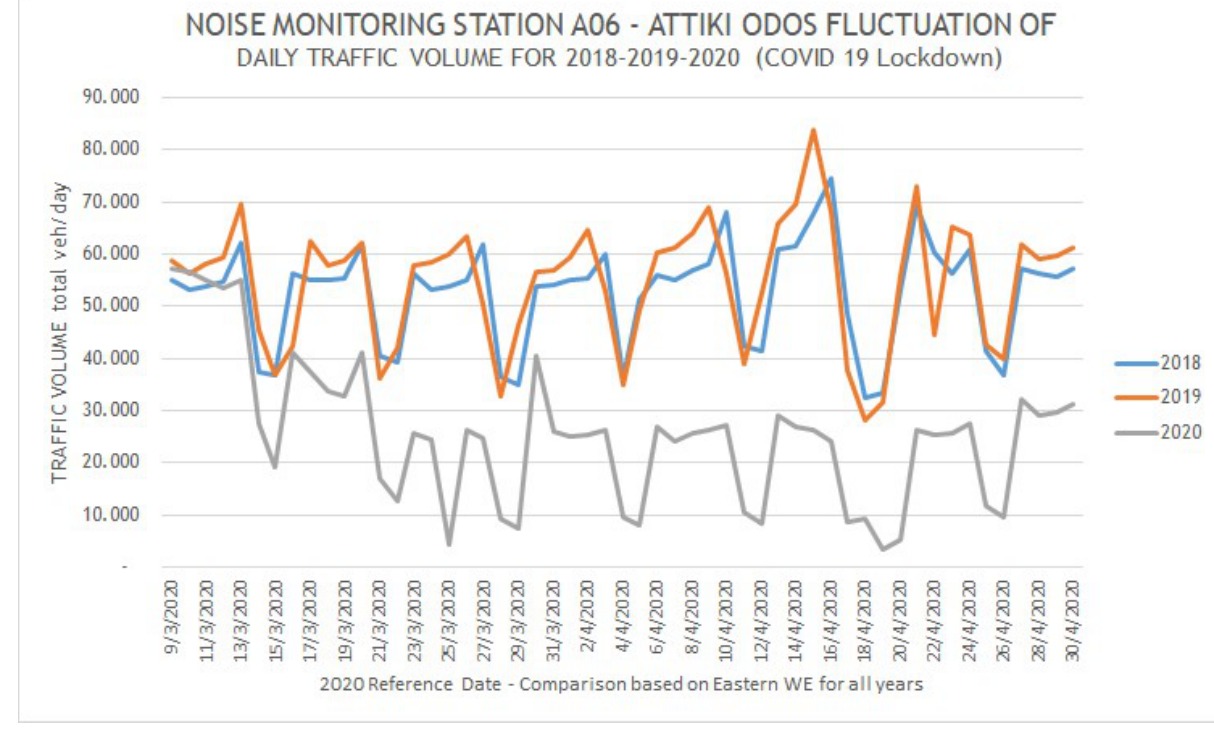
Figure 8a: Daily traflc volume – Noise monitoring station A06